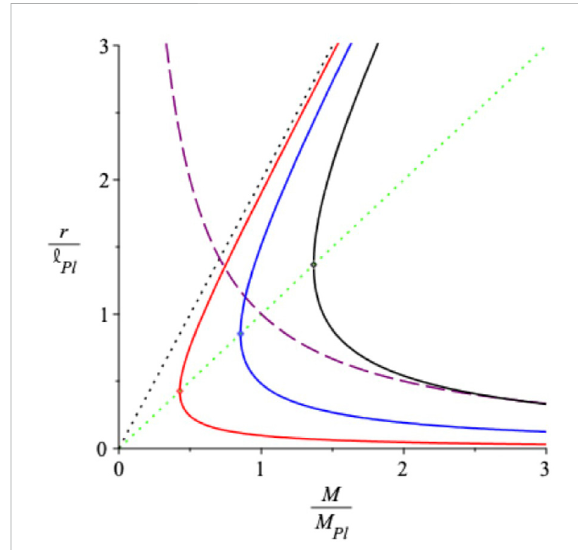
FIGURE 3 The solid curves show the outer and inner horizons for a standard RN black hole with n = 5, 11, 16 (left to right). For each n , the horizons meet at the extremal mass on the line r (cid:2) M / M 2 P (green dotted) and are bounded from above by the Schwarzschildradius r S (cid:2) 2 M / M 2 P (blackdottedline).TheCompton curve is shown by the dashed line and the inner horizon asymptotes to this for n = 16. Solutions with 11 < n < 16 penetrate the sub-Planckian RN regime. From Carr et al.